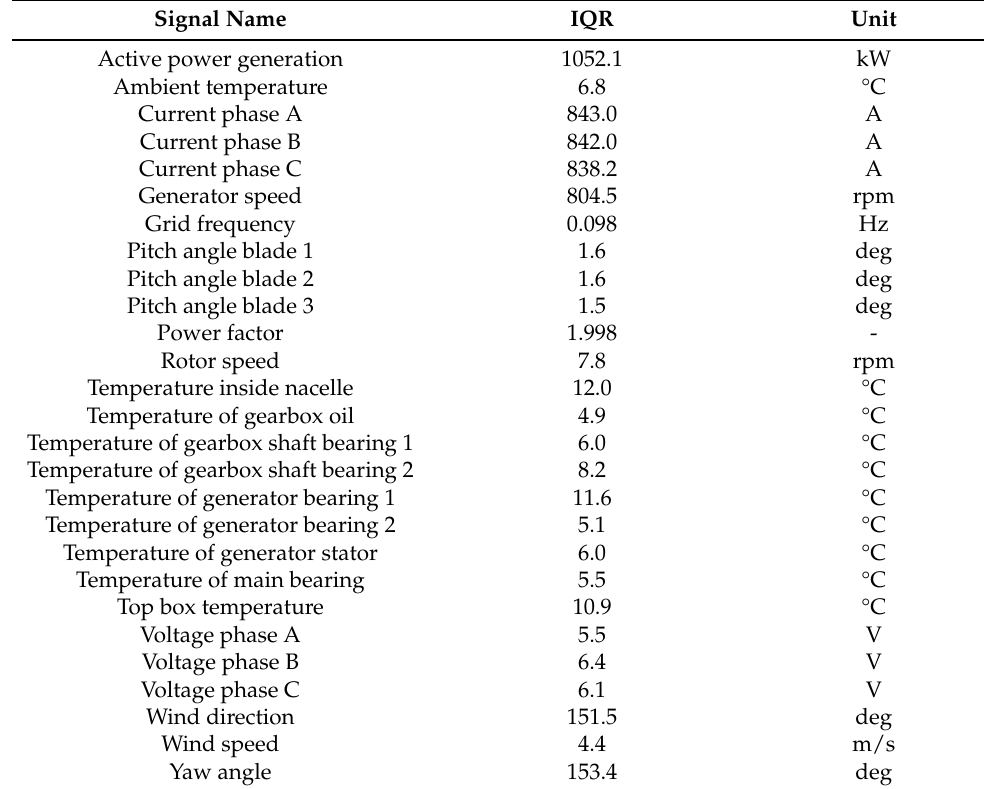
Table 4. List of the available signals and corresponding interquartile range values used to normalize results for comparability. The IQR is defined as the difference between the third and first quartile of a